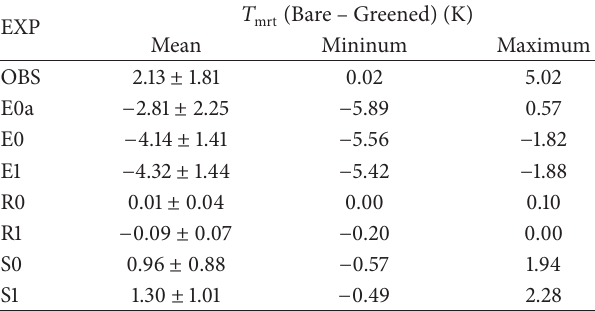
Table 8: Mean ( ± standard deviation), minimum and maximum between bare and greened site in observation difference in 𝑇 mrt (OBS) on 7, 23, 2013 (10–16 CET) and experiments (EXP) with ENVI-met 3 (E0a), ENVI-met 4 (E0 and E1), RayMan (R0 and R1) and SOLWEIG (S0 and S1).